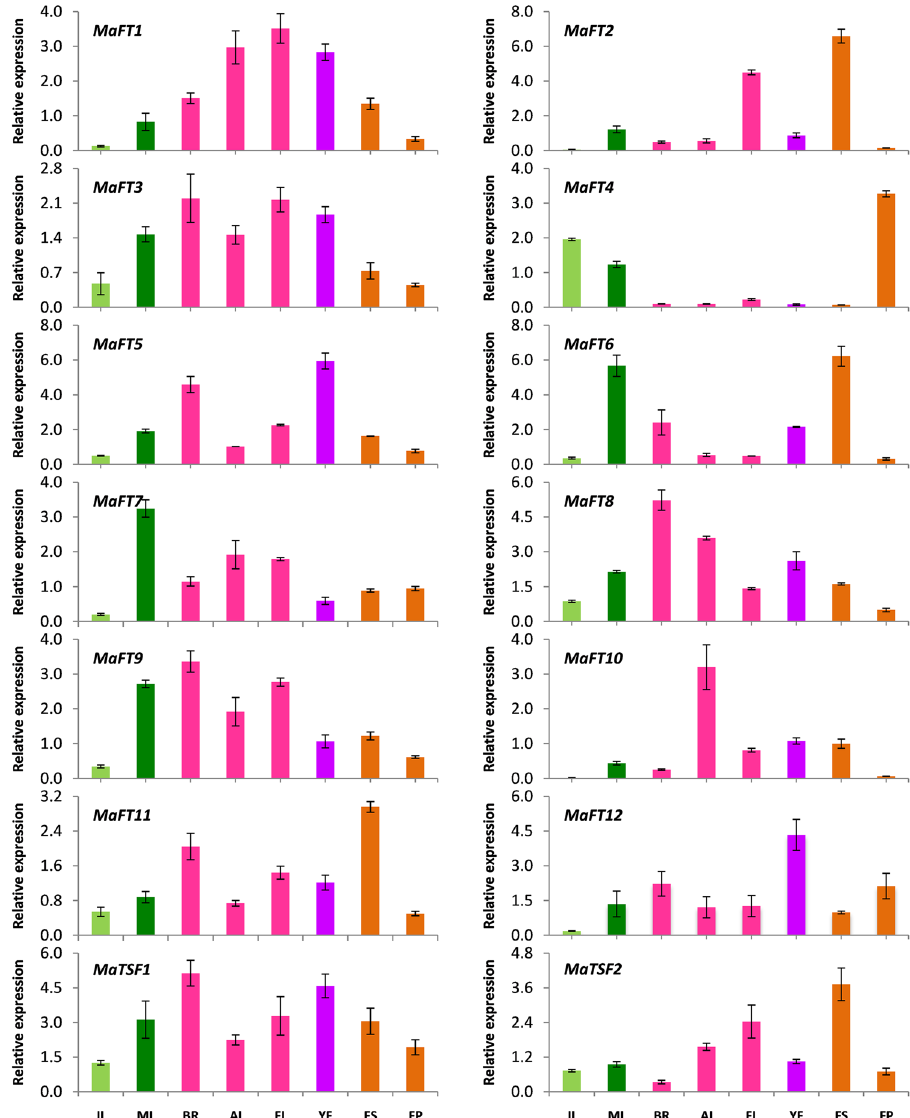
Figure 8. Tissue and organ-specific expression of banana FT / TSF -like genes. The relative expression was normalized against RPS2 . The values are means of three biological and three technical replicates ( ± SE). JL- juvenile leaf, ML-mature leaf, BR-bract, AI- apical inflorescence, FL- mature flower, YF-young flower, FS-fruit skin, FP-fruit